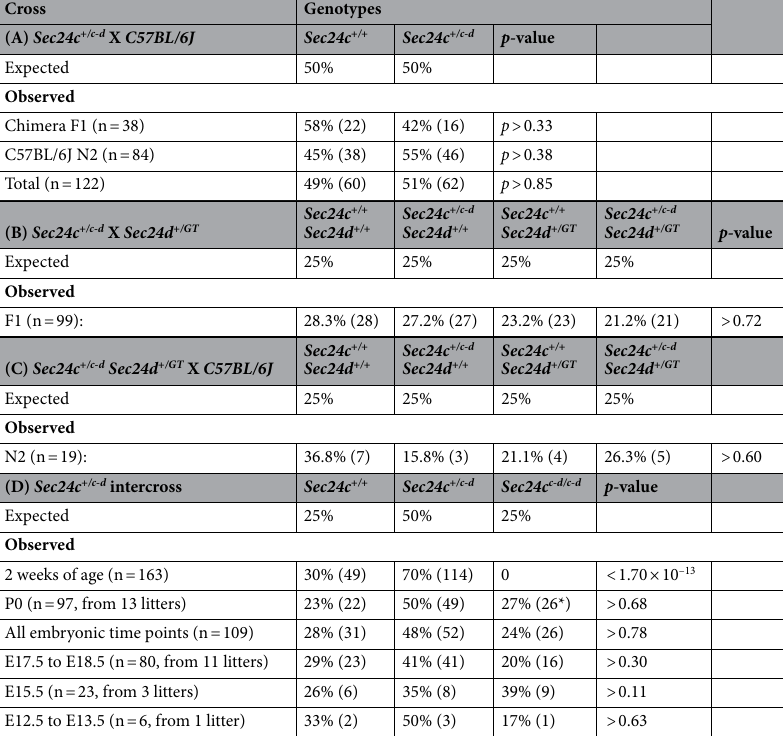
Table 1D shows the dis-